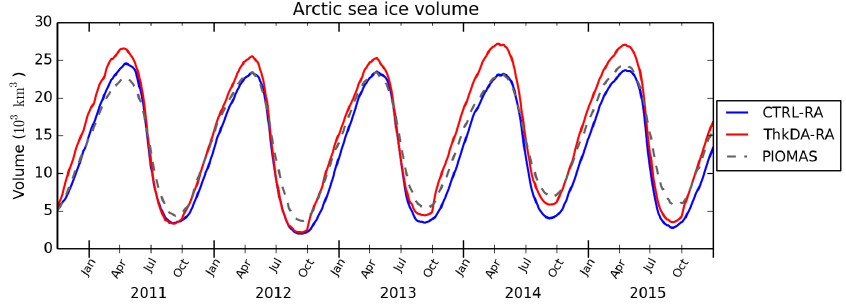
Figure 2. Reanalysis Arctic sea ice volume from 1 October 2010 to the end of December 2015 from the CTRL-RA (blue) and ThkDA-RA (red) reanalysis experiments. Sea ice volume from the PIOMAS model (grey dashed) is included as a reference.